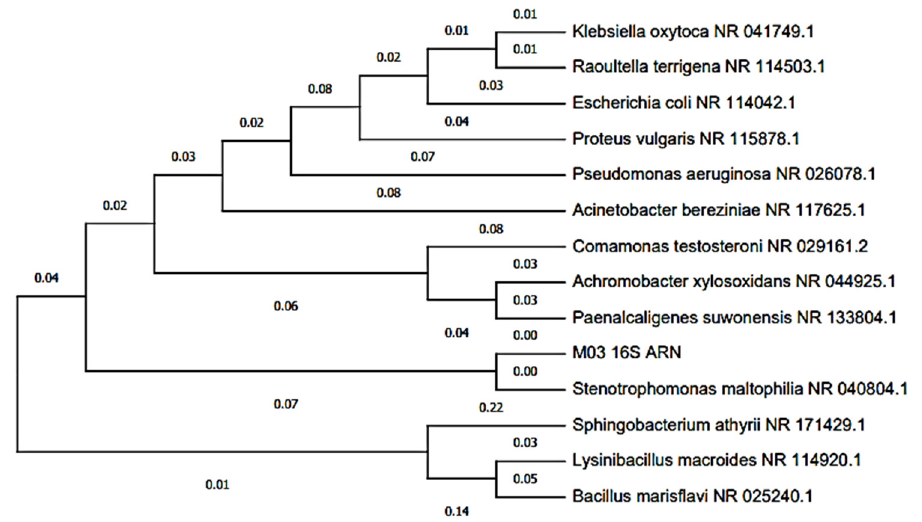
Figure 6. Dendrogram based on the 16S rDNA of a Stenotrophomonas maltophilia culture isolated from an MFC anode plate.